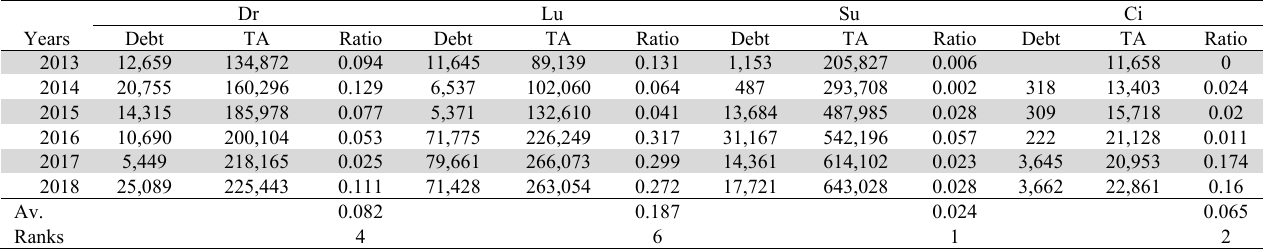
Debt-TA Ratio and rankings of Indian pharmaceutical companies (Rs. in Million)